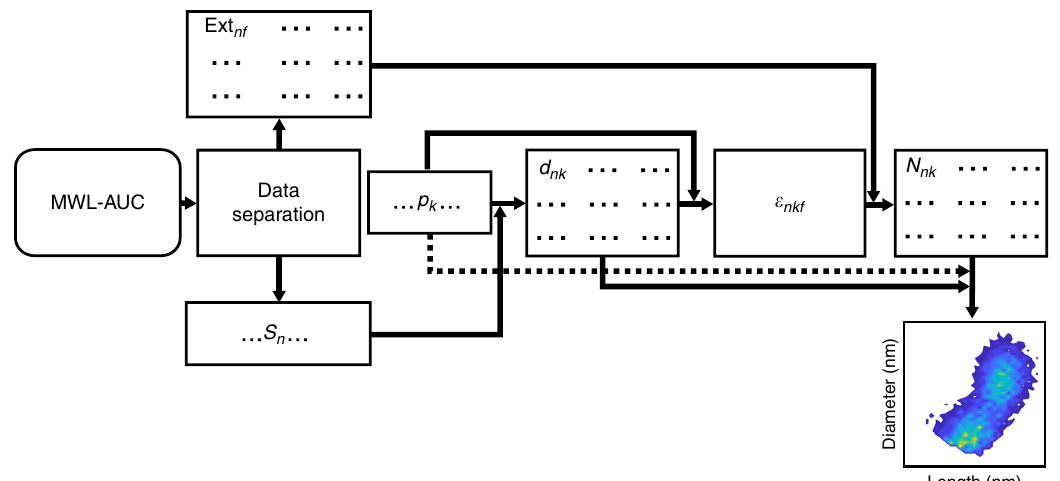
Fig. 1 Information fl ow within the OBC method. The cumulative distribution at a fi xed wavelength is separated in intervals of a constant height, then the corresponding spectrum and the mean sedimentation coef fi cient are deduced. Each spectrum is individually fi tted for the number concentration N of species of varying aspect ratio, length and